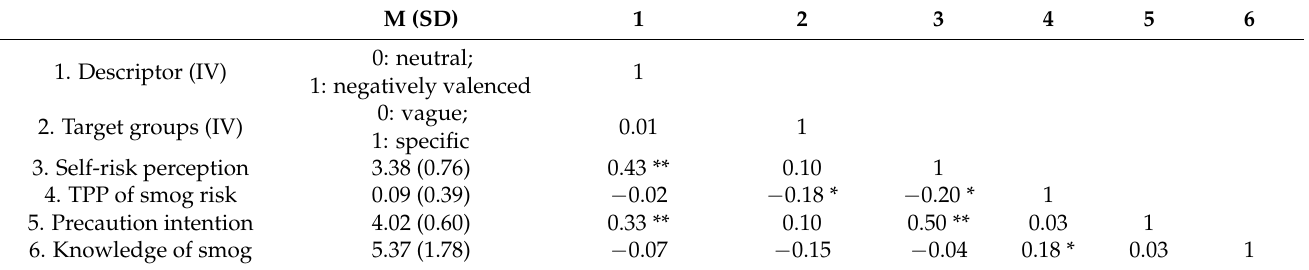
Table 2. Descriptive statistics and correlations among key variables.